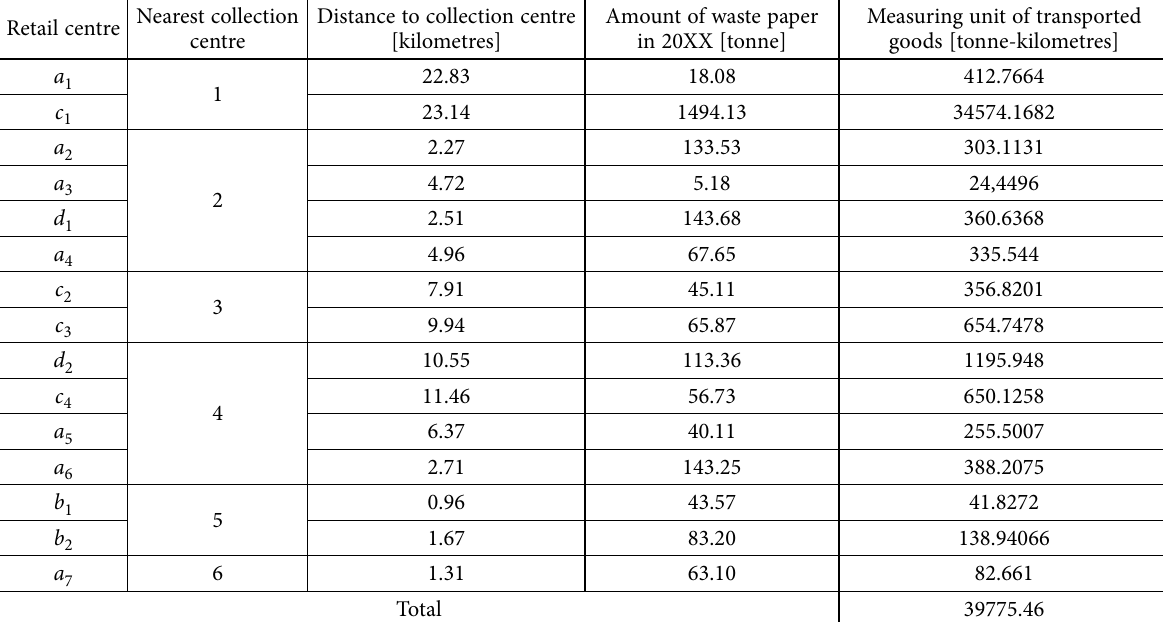
Table 2. Parameters of alternative RL network Nearest collection Retail centre centre